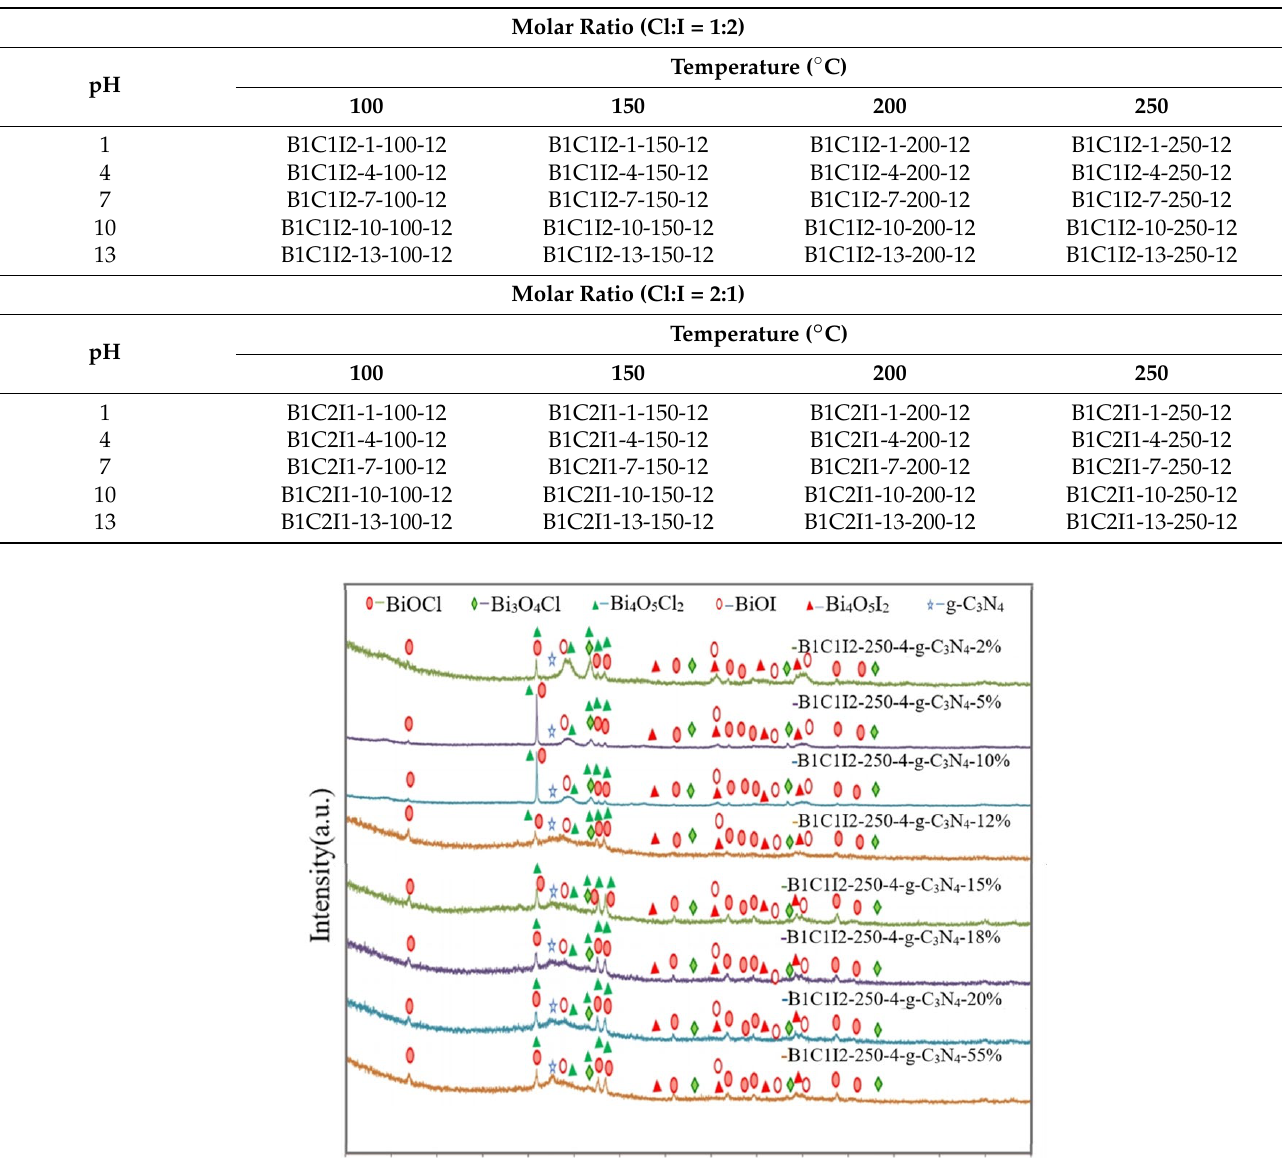
Table 1. Codes of the BiO m Cl n /BiO p I q samples produced under various reaction temperatures, different pH values, two KCl:KI molar ratios, and a reaction time of 12 h.